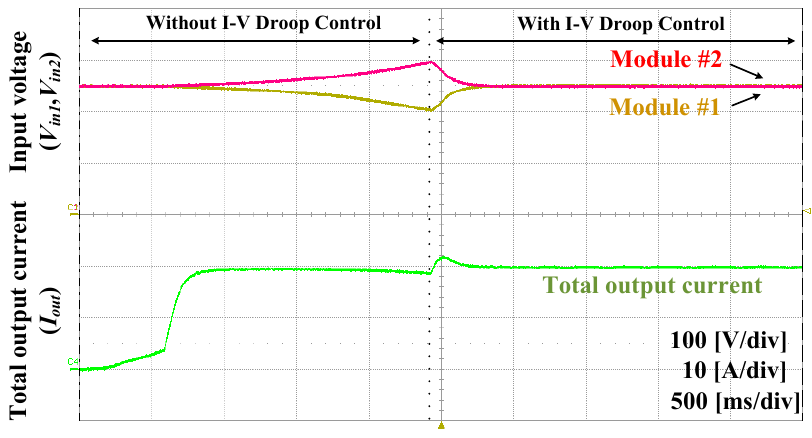
Figure 12. Experimental waveforms of total output current and individual input voltage.